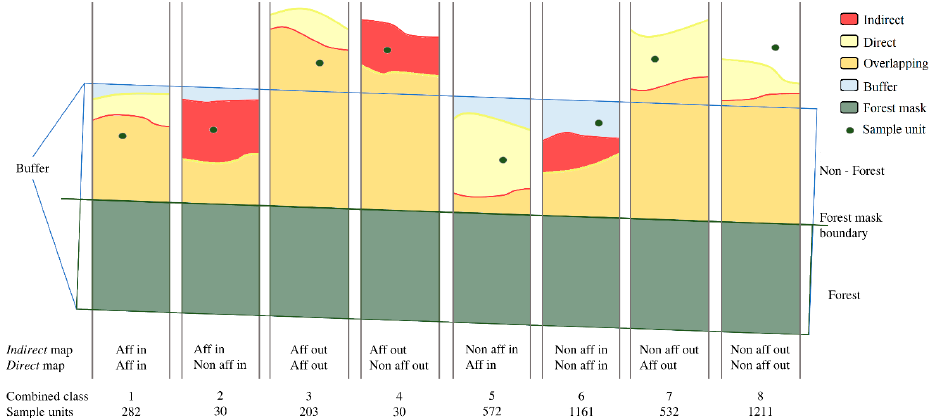
Figure 2. Graphical representation of the eight combination classes shown in Table 2. “In” and “out” refer to “inside” and “outside” the forest buffer while “aff” and “non aff” refer, respectively, to “afforestation” and to “non-afforestation”. Table 3. Accuracy assessment for direct map.